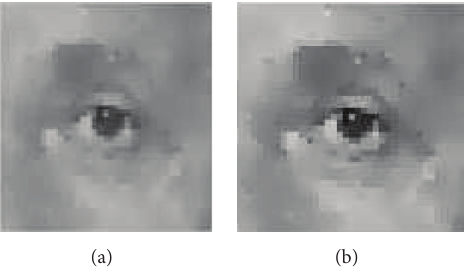
Figure 16: Image quality comparison between (a) FPGA implementation for the natural Einstein image (zoomed eye inset) and (b) MATLAB implementation. Filter parameters: Sigma ( 𝜎 ) for random noise = 12, number of iterations = 4, 𝜆 in (3) = 1/7, and Kappa ( 𝜅 ) in (4) = 15.